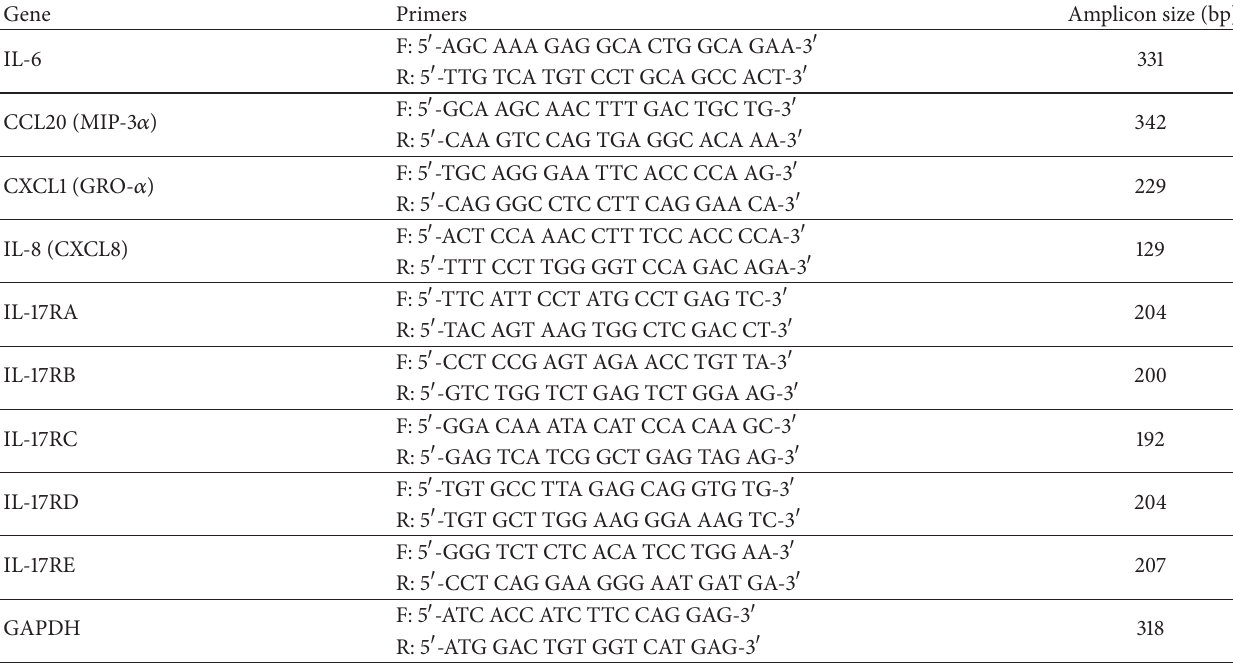
Table 1: Primers used for PCR analysis of